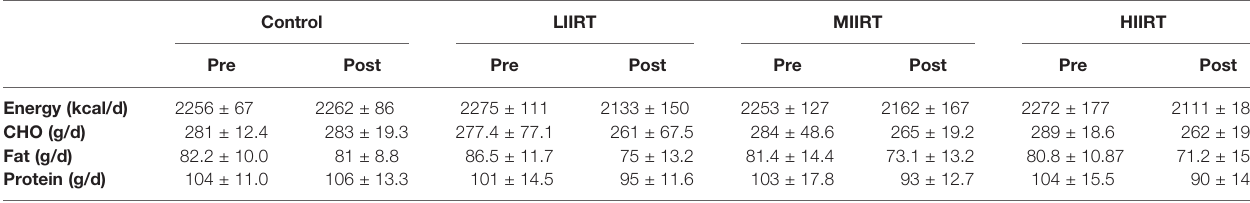
TABLE 1 | Mean ( ± SD) values of nutritional intake in the four study groups. Control